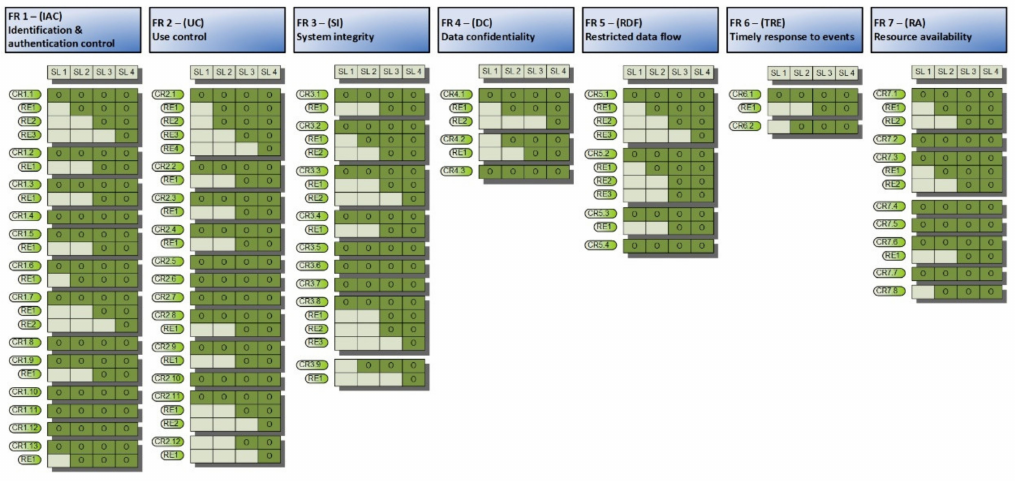
Figure 10. IEC 62443 system requirements